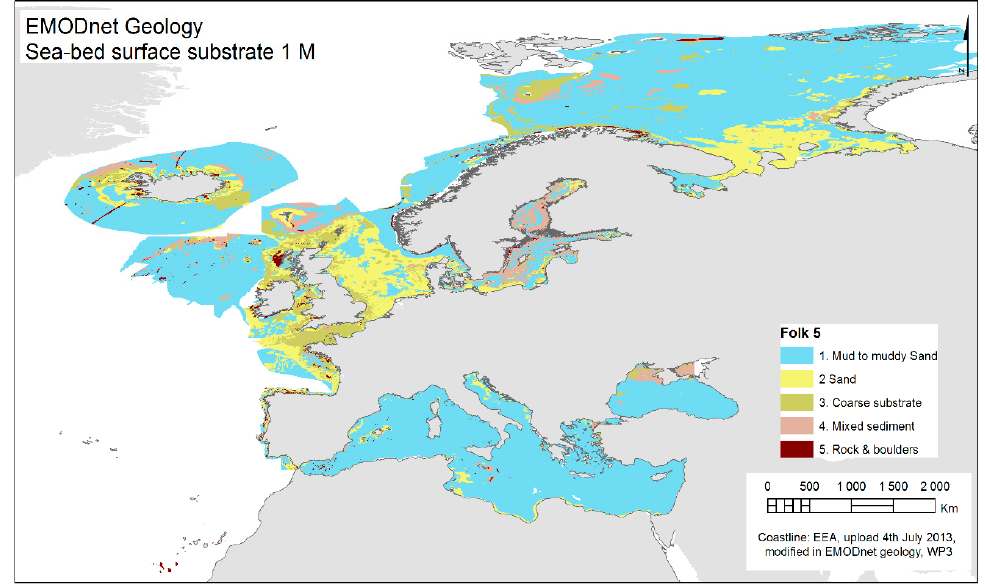
Figure 7. EMODnet Geology seabed surface substrate data at a scale of 1:1,000,000 (1 M) for the European seas, hierarchy of five Folk classes. Table 4. Approximate seabed substrate data coverage at different scales versus the extent of the sea region. Sea regions are shown in Figure 1.